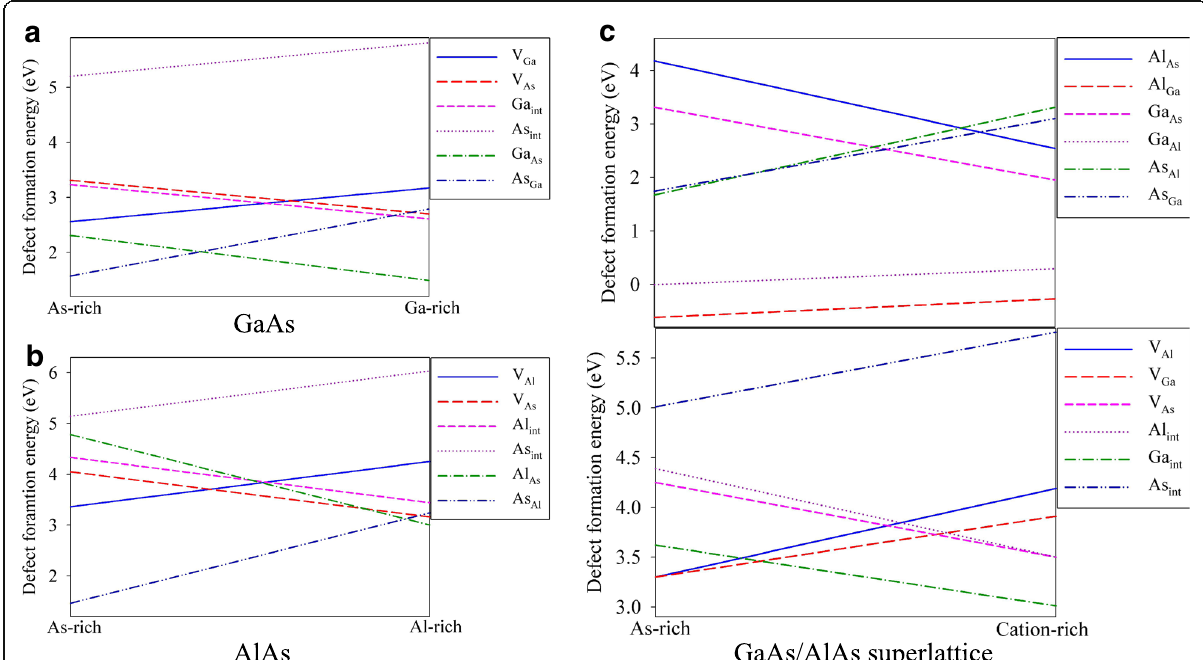
Fig. 3 The defect formation energies under As-rich and cation-rich conditions in a GaAs, b AlAs and c GaAs/AlAs superlattice. X Y : (X, Y = Ga, Al, or As) X occupying the Y lattice site; V X : X vacancy; X int : X interstitial